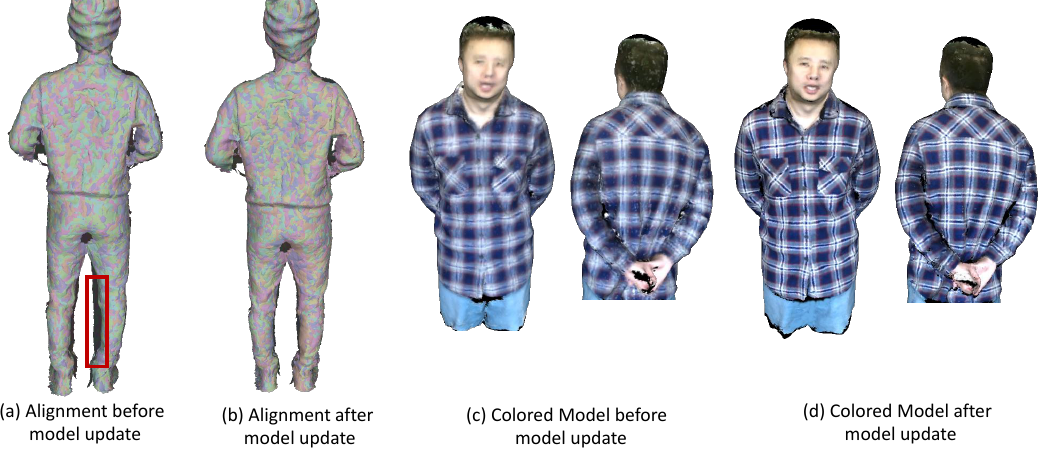
Figure 8. Illustration of results before and after model update. ( a , b ) show all the aligned pieces before and after the model update step, respectively. The misalignment still exists around the legs as marked red after the global registration. The alignment has gotten better after our model update as shown in ( b ). Some colored models are shown in ( c , d ). The appearance before model update ( c ) is quite blurry, while more clear and consistent color maps have been achieved after the model update ( d